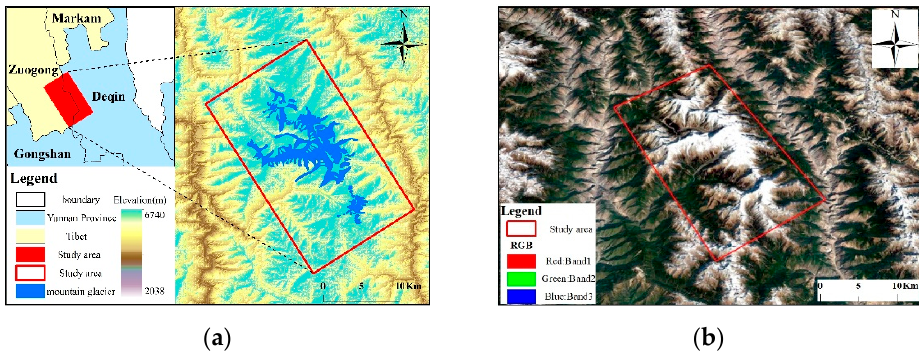
Figure 1. Location study area location. ( a ) Location and topography of the study area. ( b ) High resolution remote sensing image map of the study area, true color composite from R, G, and B bands.